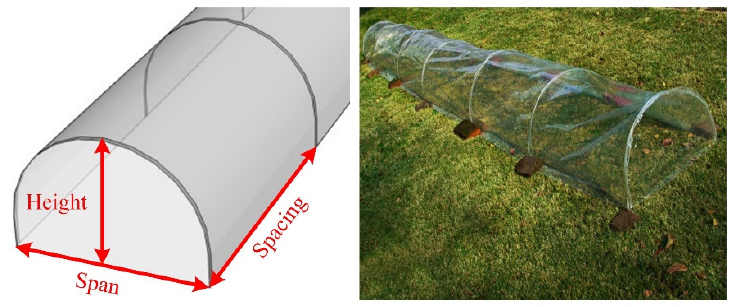
Figure 1. Plastic-film-covered cultivation in an arch